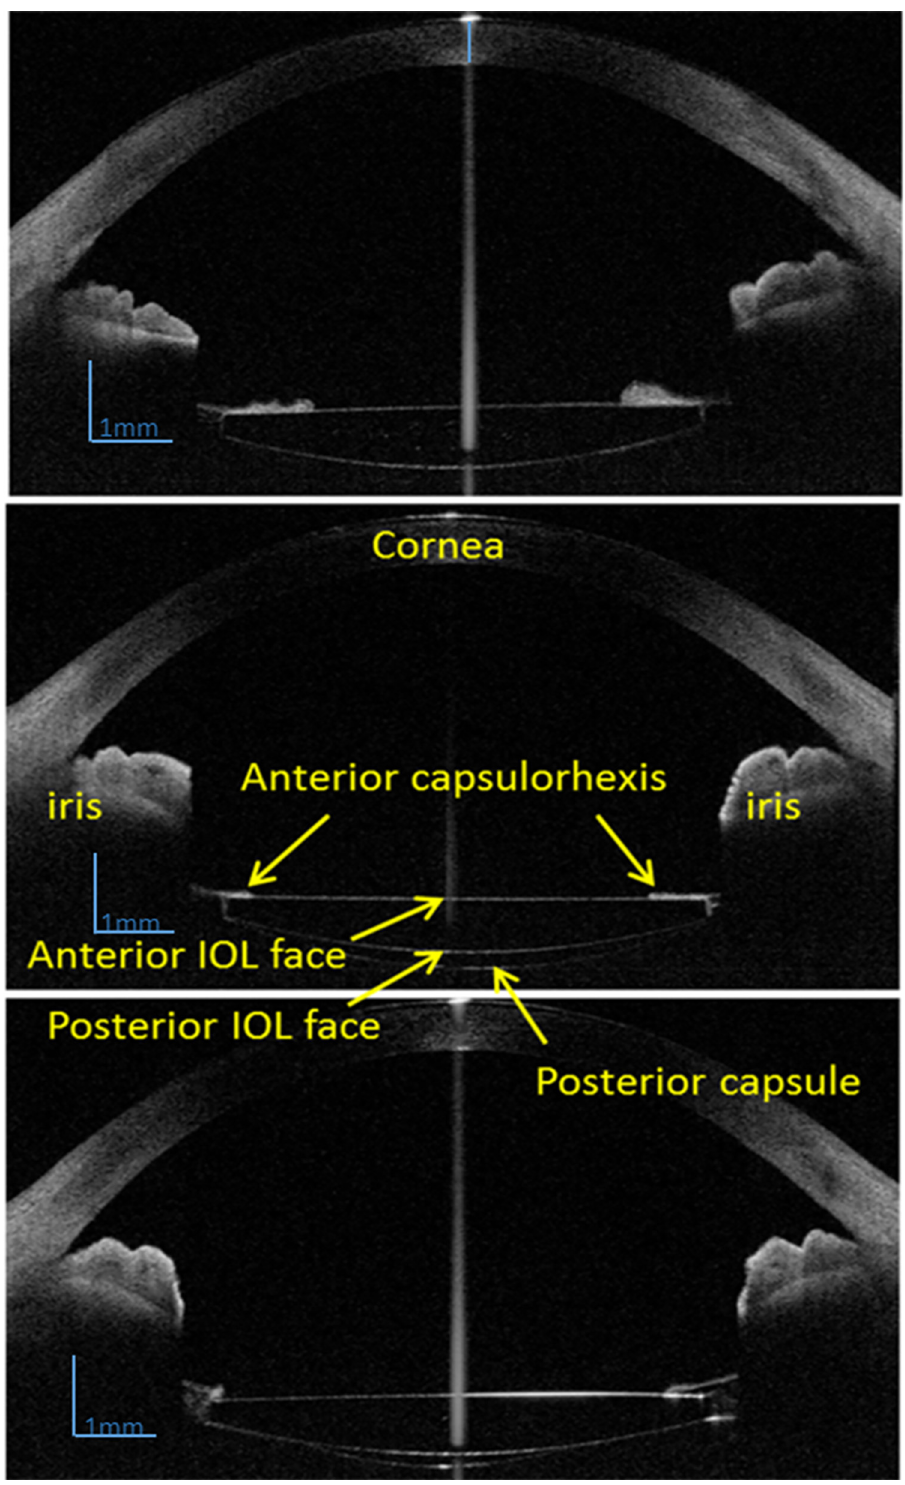
Fig 2. The anterior segment images of high-speed swept-source optical coherence tomography (SSOCT).